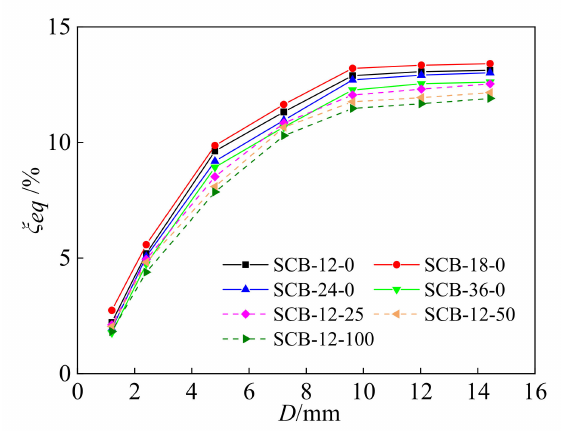
Figure 12. Equivalent damping coefficient of self-centering SMA brace